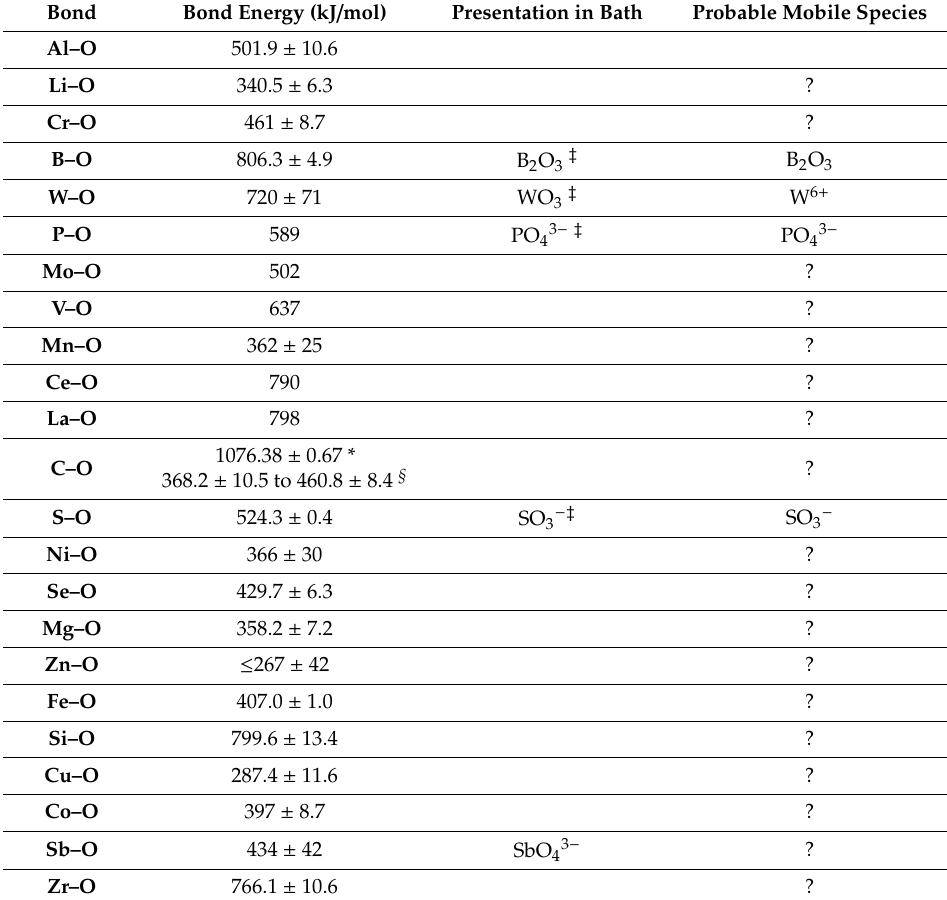
Table 2. Binding energies of relevant bonds in the anodization bath.